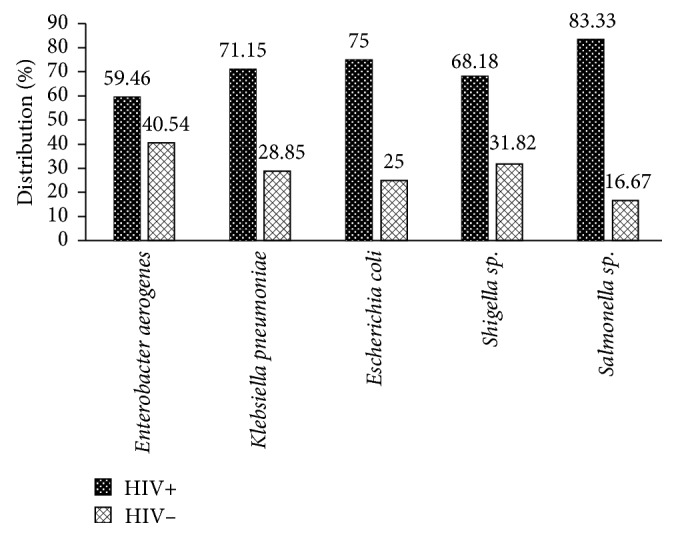
Distribution of intestinal bacteria pathogens among patients with enteric disorders enrolled in the study.